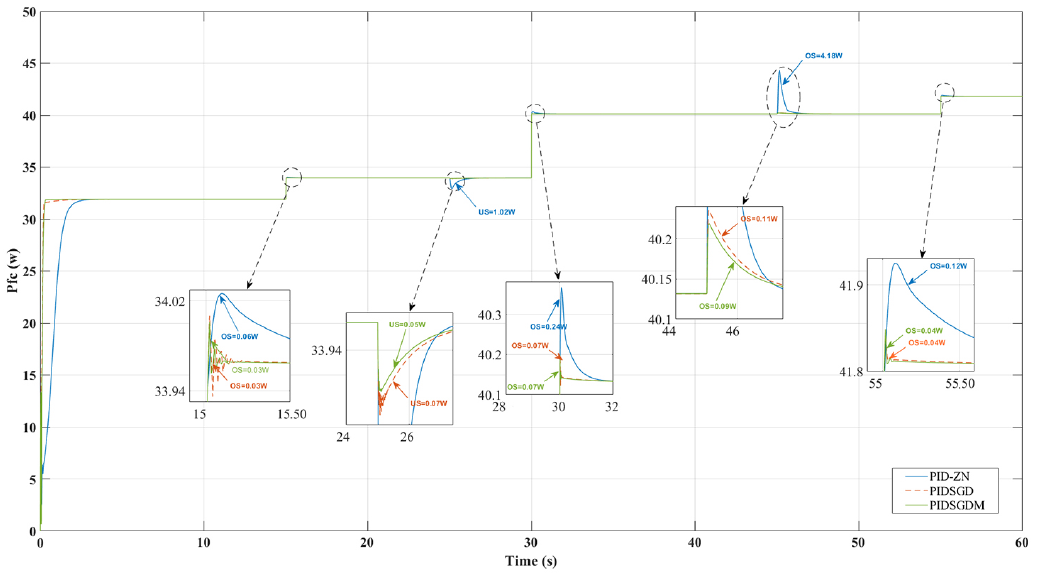
Figure 13. PEMFC stack output power.